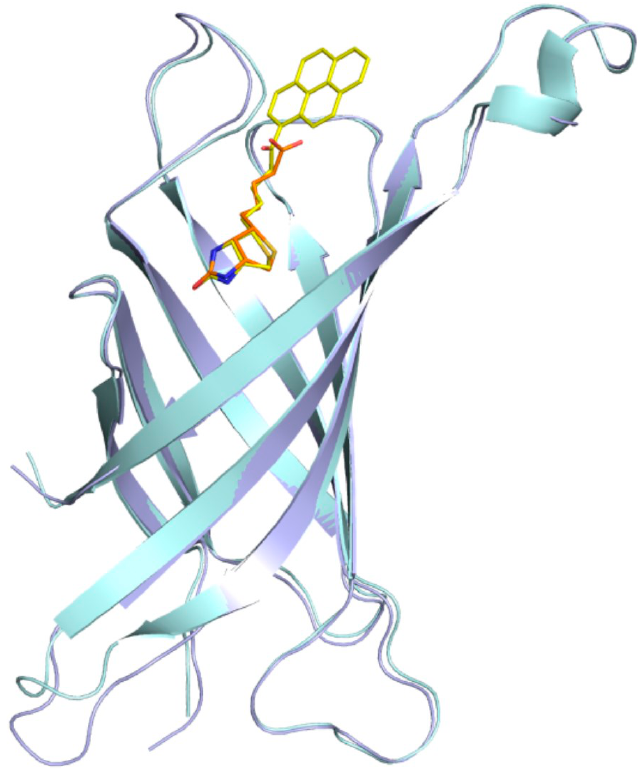
Figure 4. Superposition of the avidin–biotin structure (cyan/orange) with the avidin/B9P structure (light blue/yellow). The structures were superimposed on corresponding C α atoms. (light blue/yellow). The structures were superimposed on corresponding C α